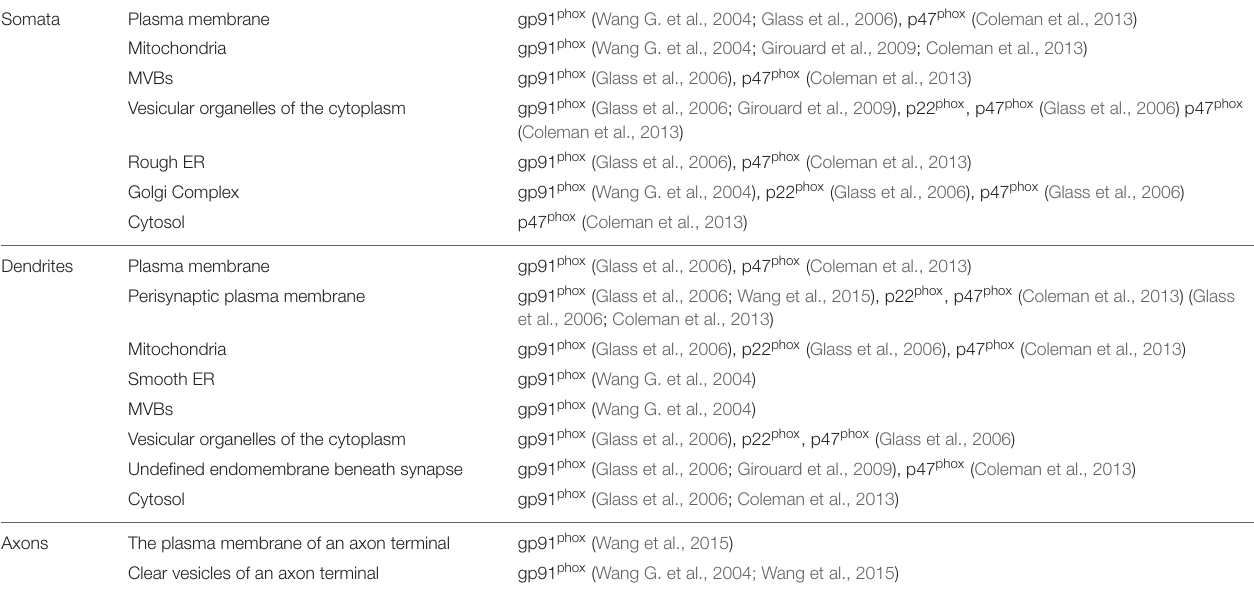
TABLE 1 | The subcellular distribution of NOX2, p22 phox , and p47 phox observed by immunolabeling in neurons (Wang G. et al., 2004; Glass et al., 2006; Brennan et al., 2009; Girouard et al., 2009; Minnella et al., 2018).